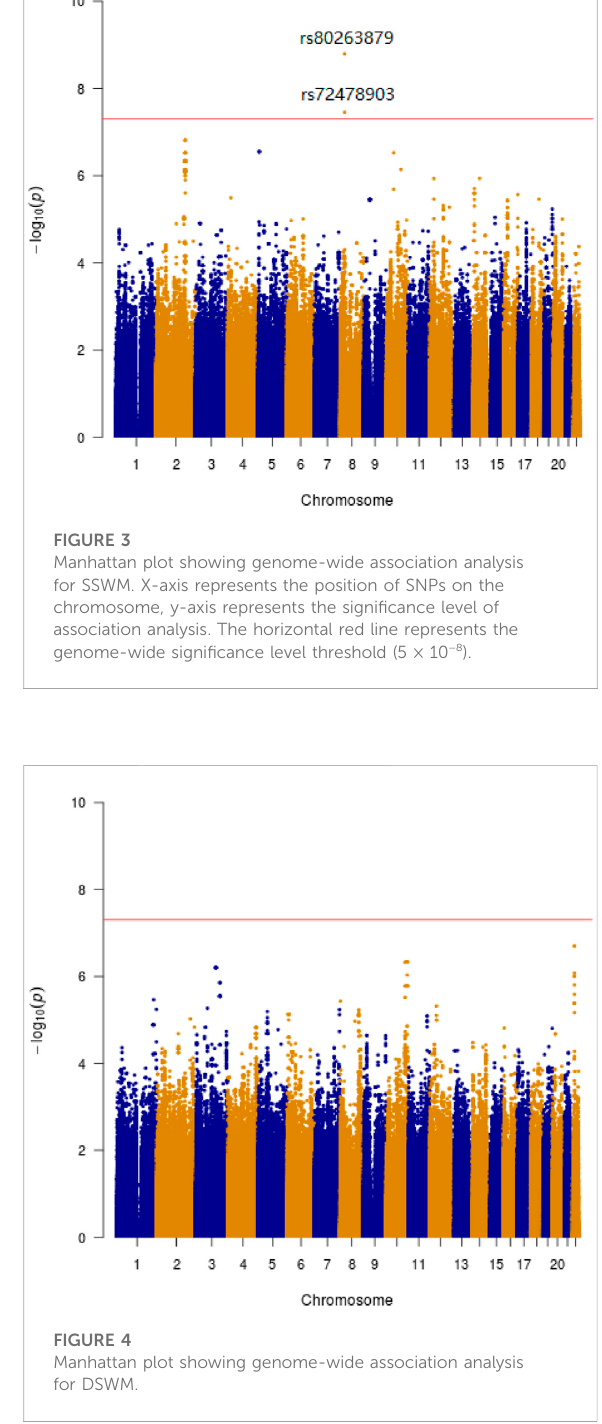
TABLE 1 Correlations for sociodemographic variables (gender and grade) and phenotypes (SSWM and DSWM).